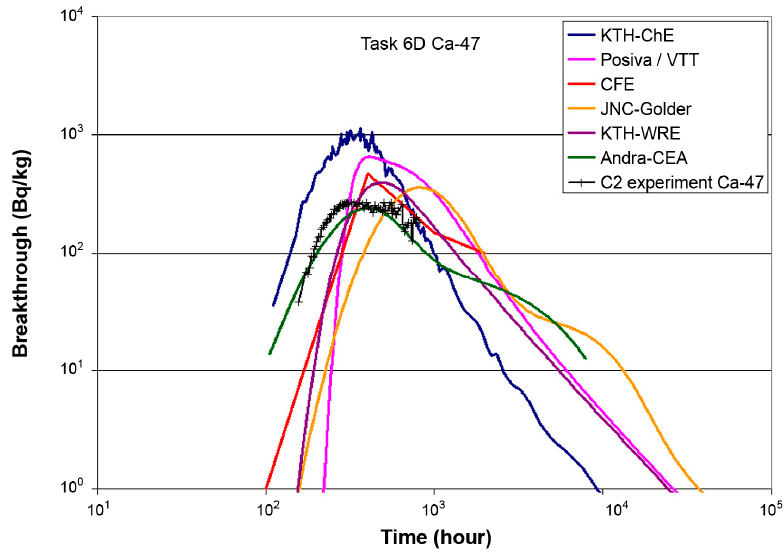
Figure 3. Inter-comparison of calculated breakthrough curves for Ca-47 in Task 6D together with the TRUE Block Scale C2 tracer test results [19].